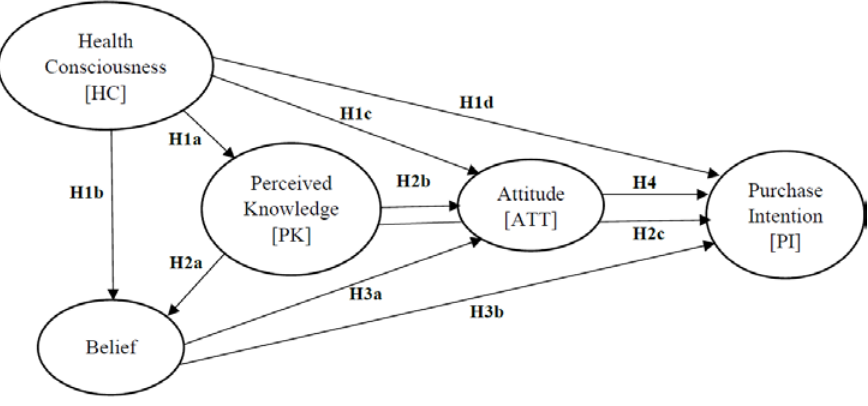
Figure 1. Conceptual model.